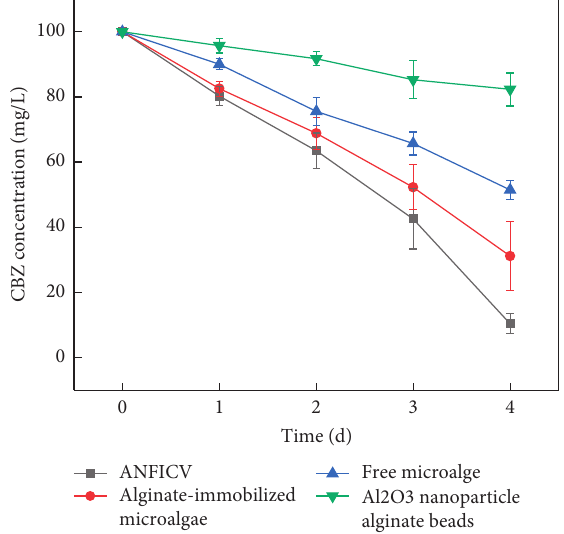
Figure 1: The growth curves of C. vulgaris immobilized in beads with and without Al 2 O 3 nanoparticles.